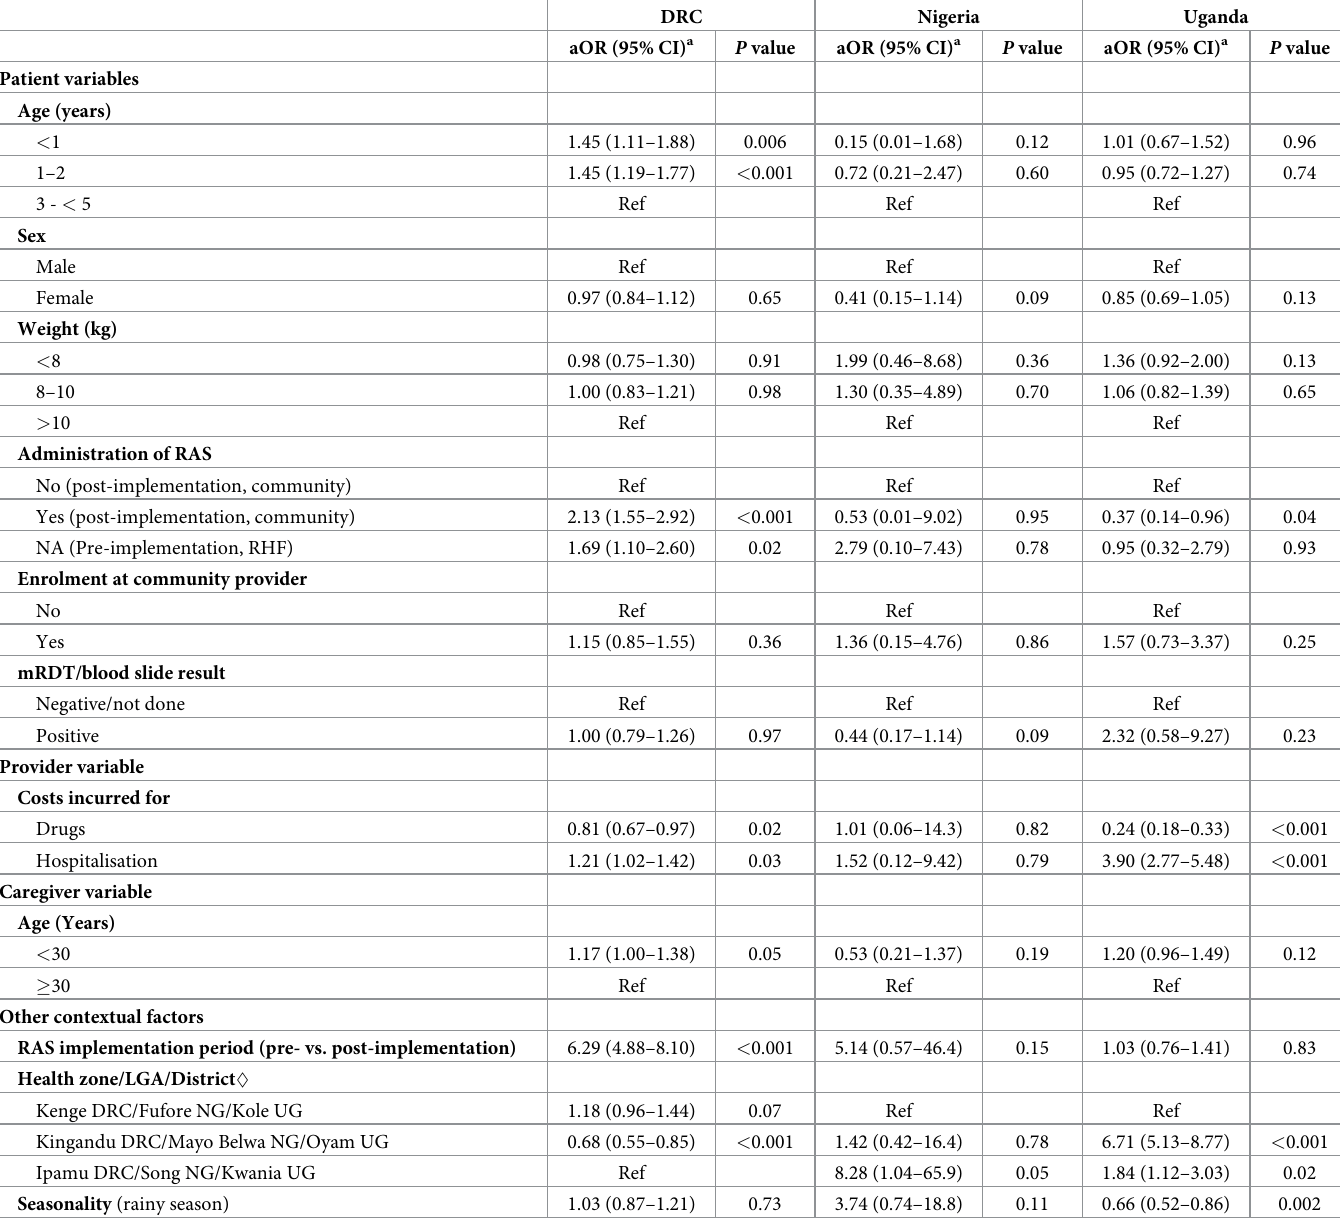
Table 3. Patient, provider, caregiver, and facility correlates with antimalarial medication appropriateness according to the WHO malaria treatment